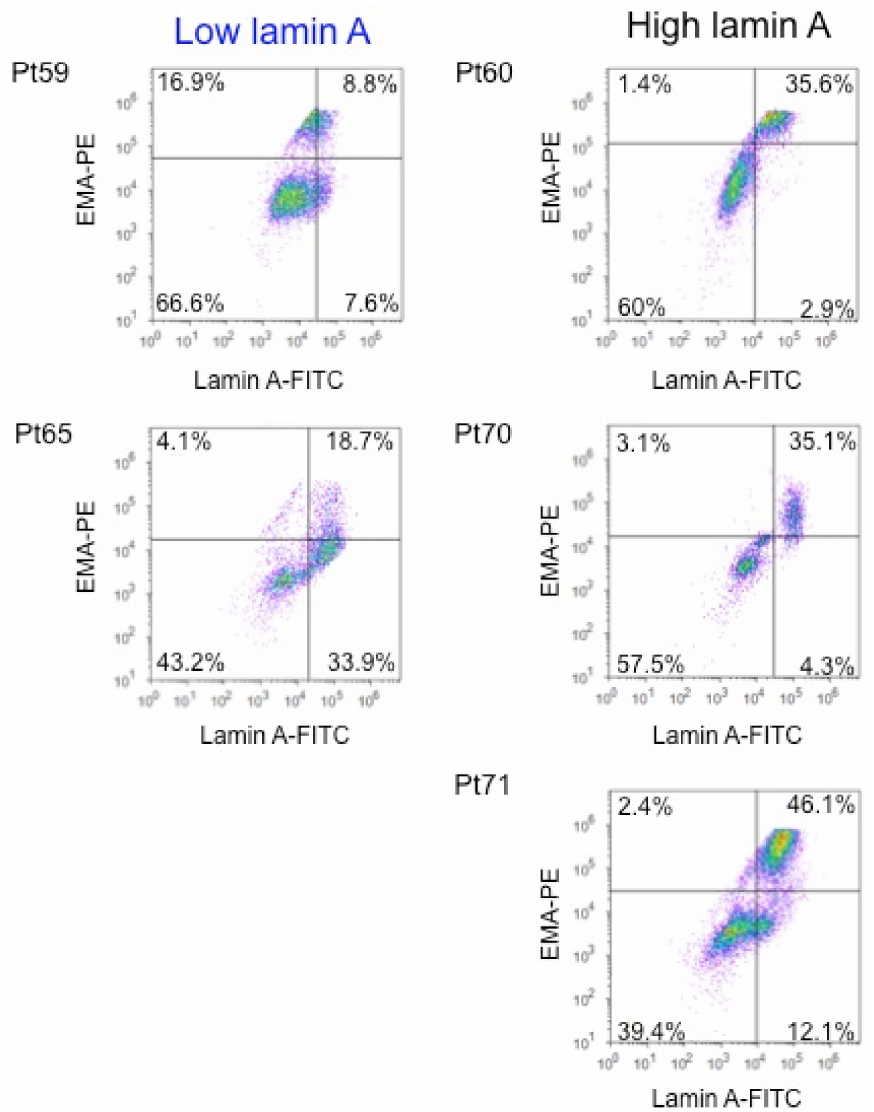
Figure 2. Flow cytometry analysis of lamin A and epithelial membrane antigen (EMA) in adenocarcinoma cells from pleural e ff usions. Representative results of lamin A and EMA expression in malignant cells contained in metastatic pleural e ff usions from lung adenocarcinoma (left panels = Patients (Pt) 59 and 65, from the ‘Low Lamin A expression’ group and right panels = Pt 60, 70, and 71, from the ‘High Lamin A expression’ group) using flow cytometry. Positivity thresholds were defined using isotype